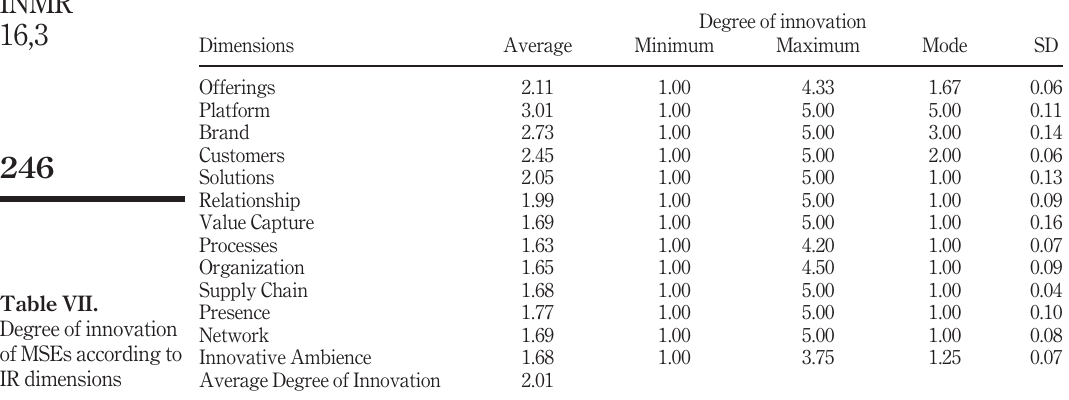
Table VII. Degree of innovation of MSEs according to IR